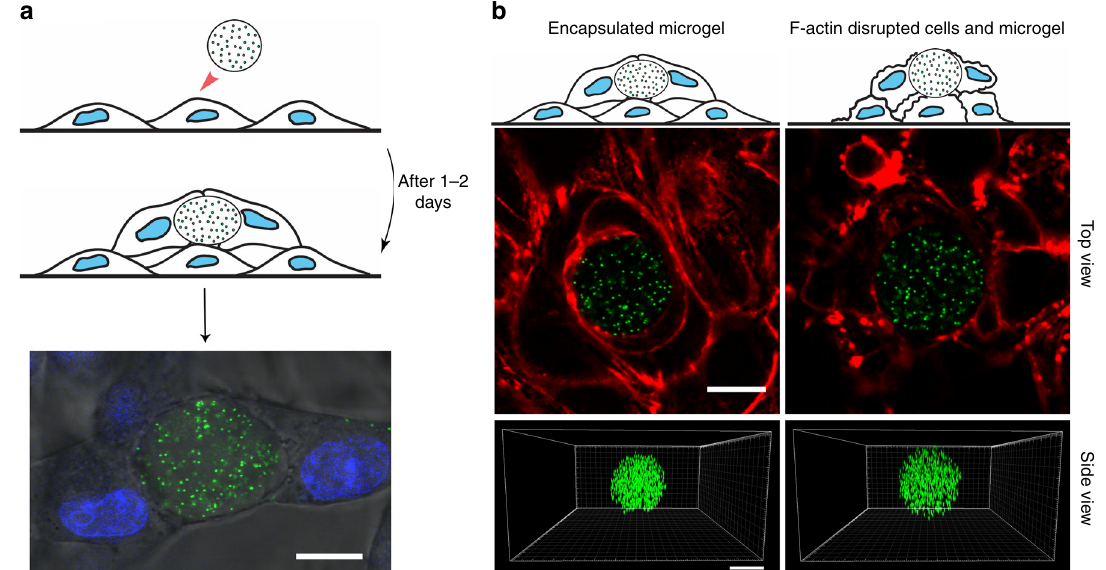
Fig. 2 Elastic round microgels in multilayered melanoma cells. a Top and middle panels, experimental procedures. Bottom panel, a microgel (Young ’ s modulus of 1440 Pa) encapsulated by cells. Note that the microgel is deformed. Blue, nuclei of the cells. Scale bar, 25 µ m. b Top and side views of 3D confocal images of the same microgel between untreated live cells (left panel) and Latrunculin A (1 µ M for 90 min) treated cells (right panel). The microgel is compressed in the untreated condition. Green, 200-nm fl uorescent nanoparticles embedded inside the ERMG. Red, fi lamentous actin staining. Scale bars, 15 µ